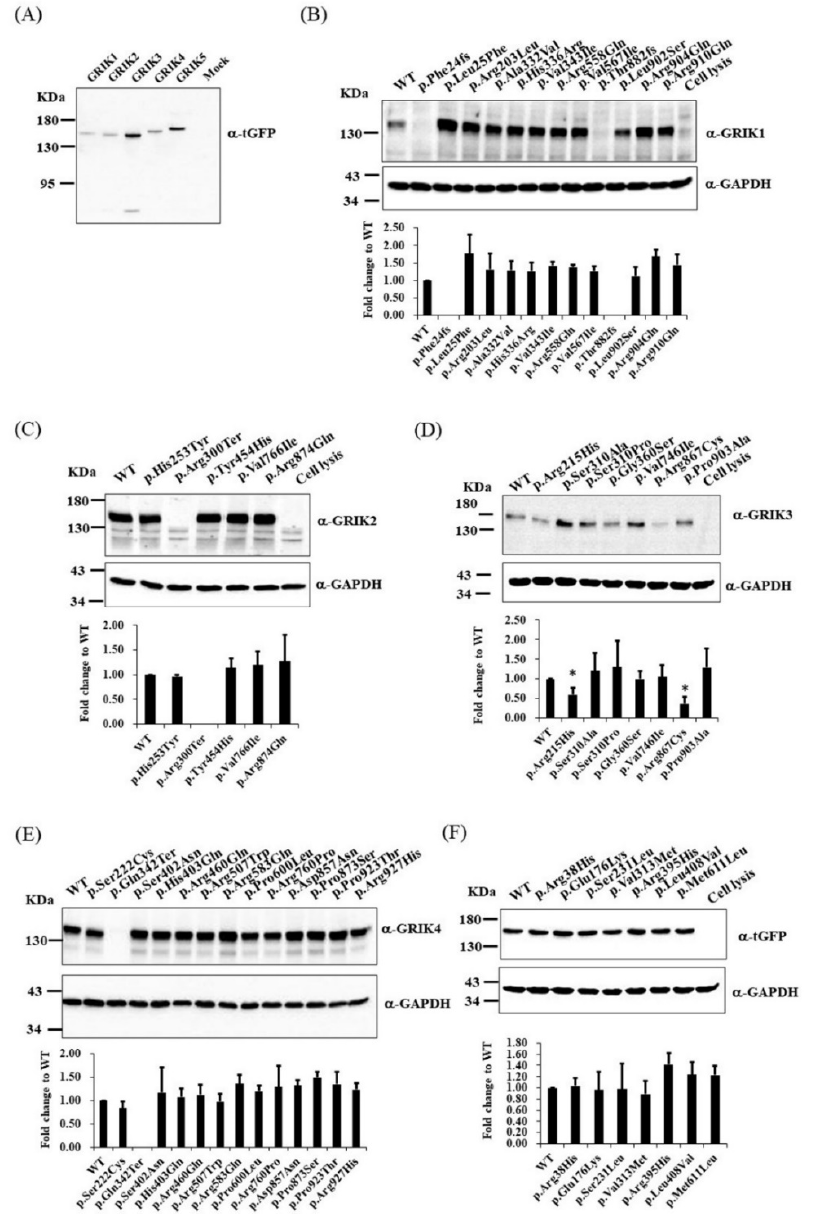
Figure 2. Immunoblotting of lysates extracted from HEK-293 transiently co-transfected with plasmids expressing either WT GRIK cDNA or mutant cDNAs. ( A ) Immunoblotting validated GRIK gene family protein overexpression in lysates using anti-tGFP. ( B ) GRIK1 WT versus 12 mutants. ( C ) GRIK2 WT versus five mutants. ( D ) GRIK3 WT versus seven mutants. ( E ) GRIK4 WT versus 13 mutants. ( F ) GRIK5 WT versus seven mutants. For normalization, the lysates were analyzed in parallel by anti-GAPDH immunoblotting. The results are representative of three independent experiments. WT, wild-type. Graphs represent means ± standard deviation. * p < 0.05.